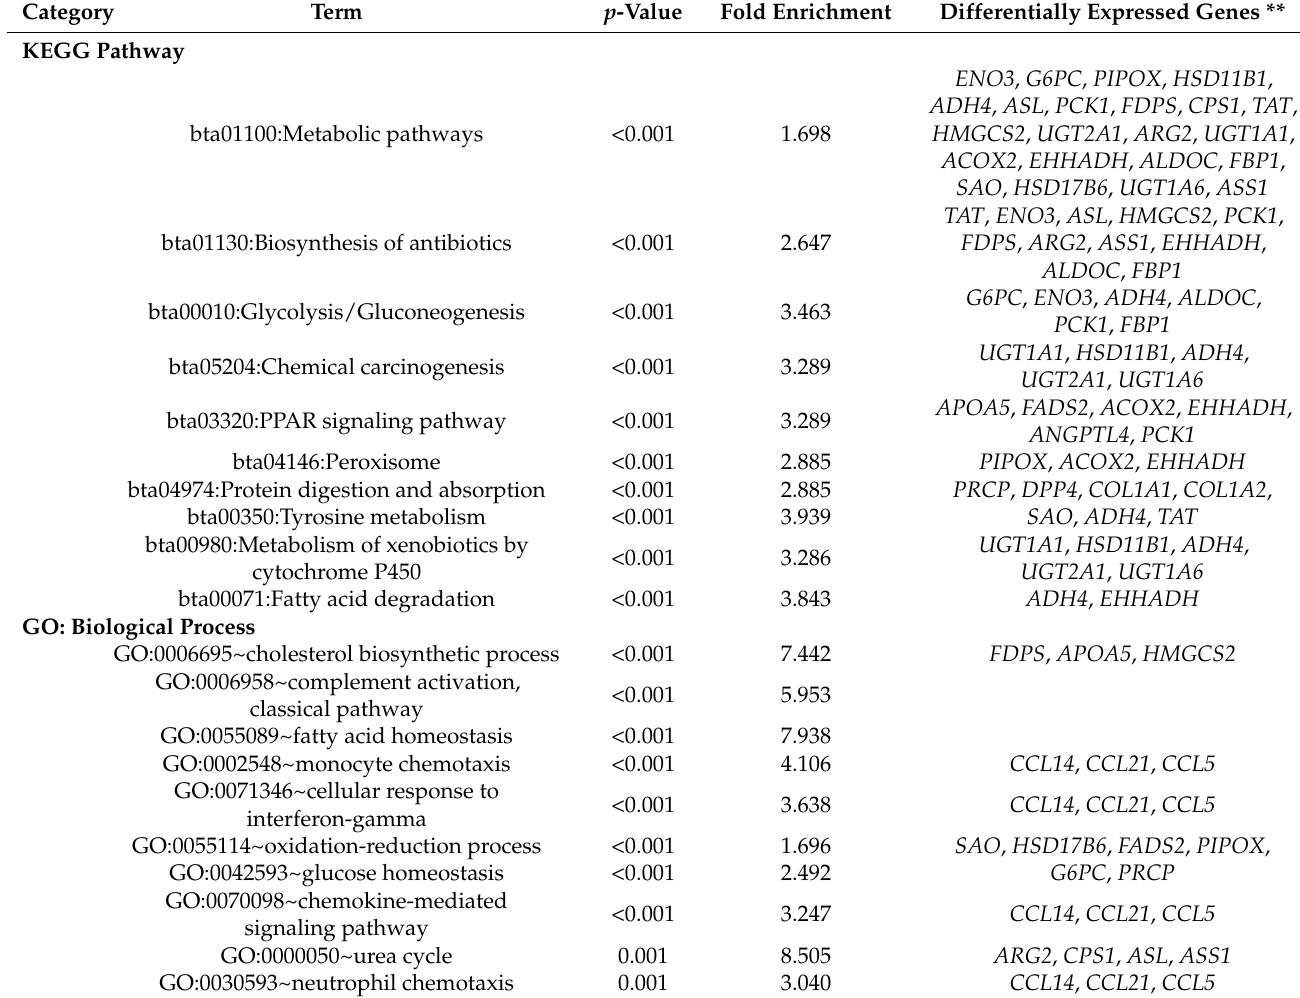
Table 4. Altered fetal liver metabolisms and pathways extracted from downregulated genes